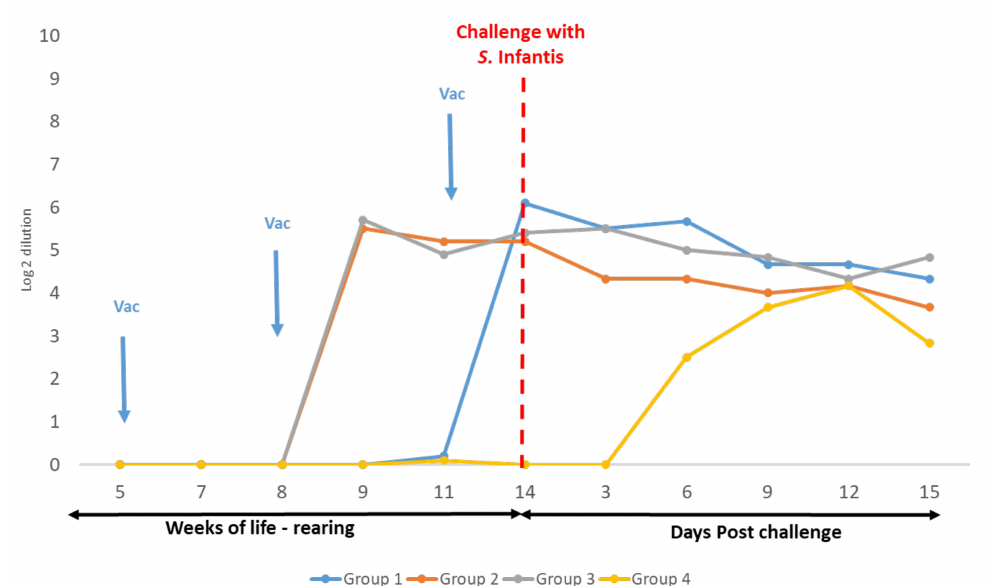
Figure 3. Trial 3—Micro-agglutination test (MAT). Measurements of titres in vaccinated (Groups 1, 2, and 3) and non-vaccinated (Group 4) chickens. Blood samples were taken approximately every 10 days starting at week 5 of life. Ten Log2 dilutions of each serum were incubated with antigens of S. Infantis. Antibody titres were calculated as the highest log2 dilution that